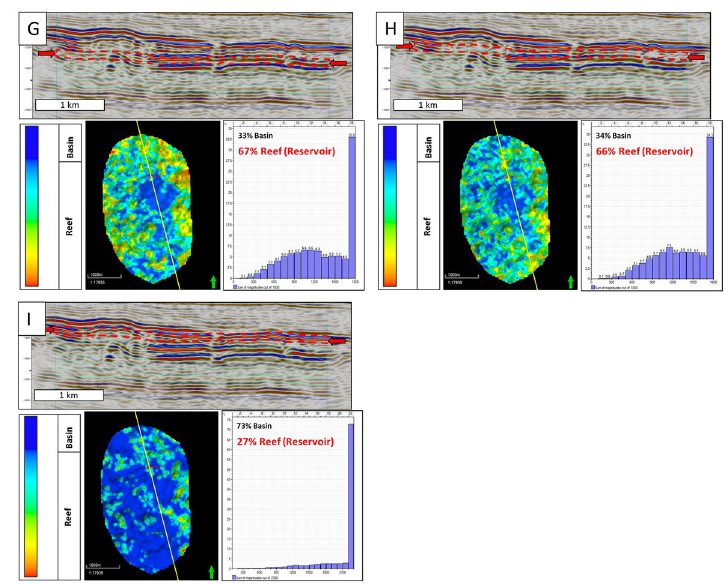
Fig. 16 Sum of magnitude maps from base to top ( G – I ) show how the amount of reservoir facies is declining dramatically. It shows furthermore the geometries of the biohermal buildups (reservoir facies) and the orientation of smaller intra-basins. Especially the upper section of the buildups is prone to karstification and a shift to shallow-water facies which could be confirmed by the borehole image